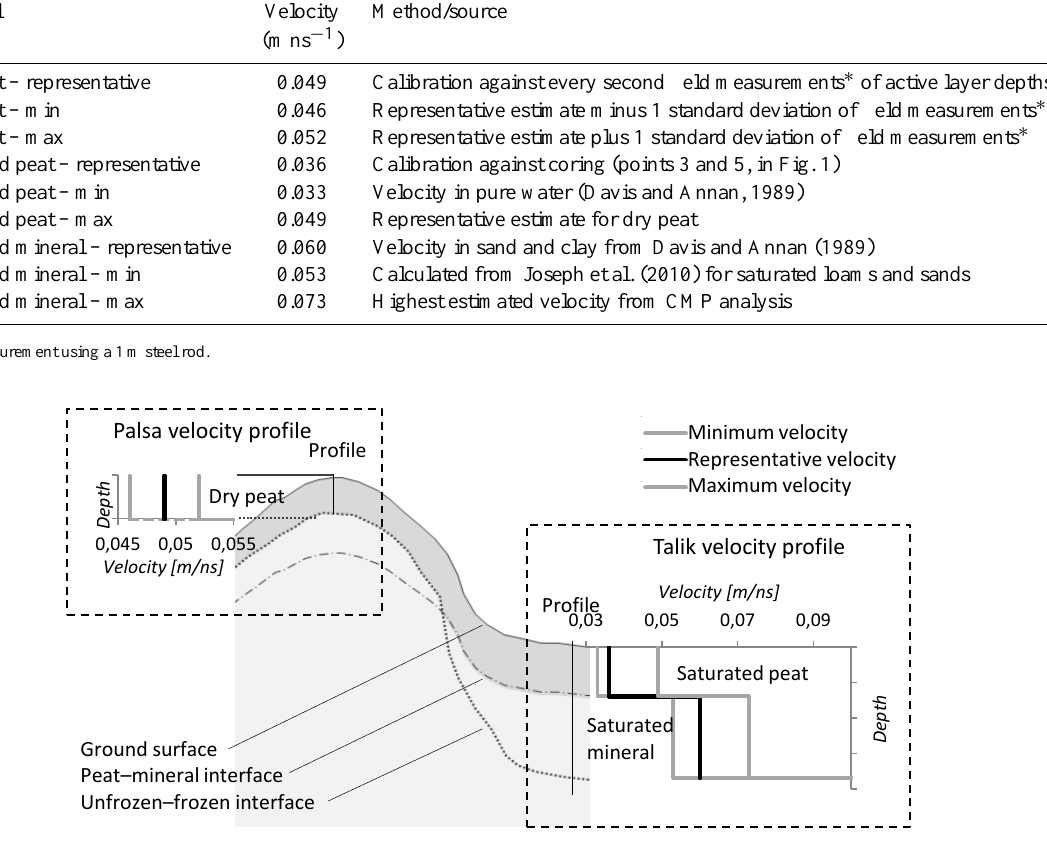
Figure 2. Conceptual sketch of typical distribution of ground substrates and associated estimated velocities for a palsa and talik ground